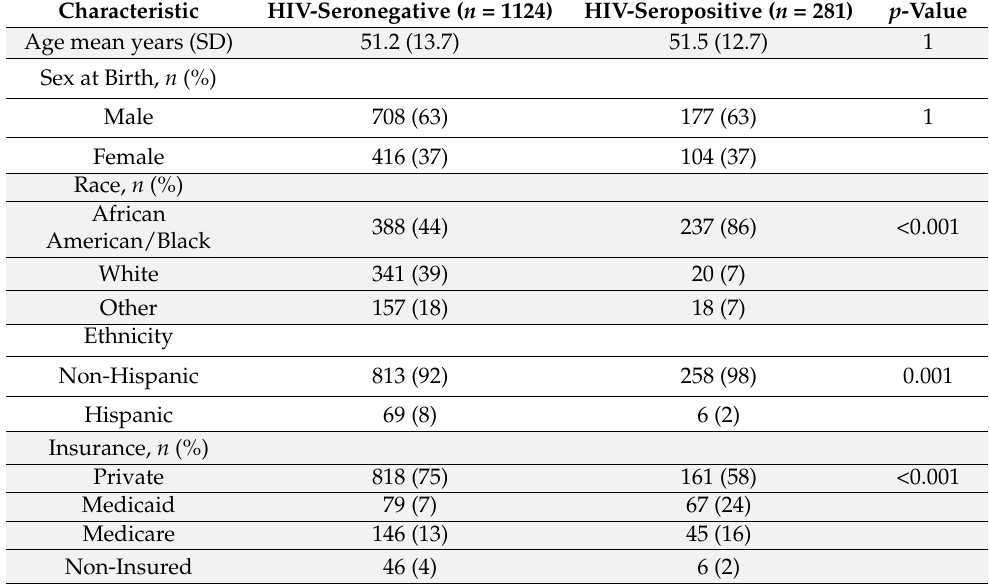
Figure 2. Persons with COVID-19 seen in the MedStar Healthcare system. Figure of persons living with HIV and HIV-seronegative individuals seen in the MedStar Healthcare system with COVID-19. Abbreviations: HIV, Human Immunodeficiency Virus; COVID-19, coronavirus disease 2019. Table 1. Comparison of age and sex matched PLWH and age/sex matched HIV-seronegative individuals with COVID-19.